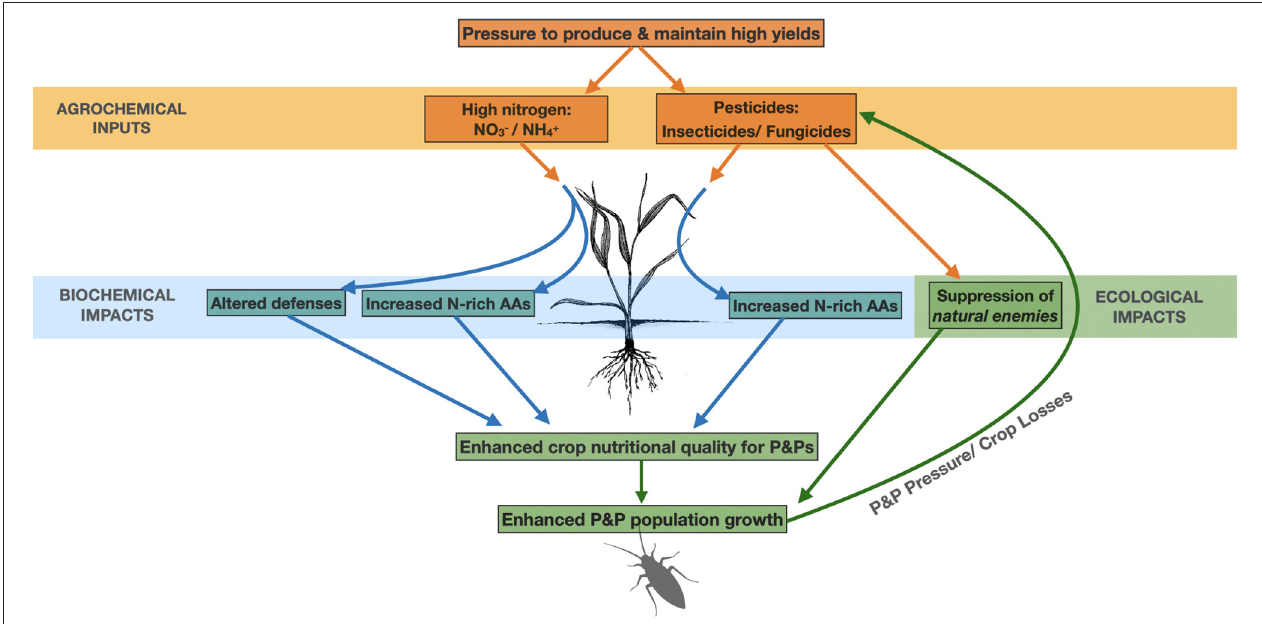
FIGURE 1 | Pathways via which the un-intended impacts of N-fertilisers and/or pesticides may reinforce the problem of pest and pathogen (P&P) damage in agriculture. Both N-fertilisers and/or pesticides can enhance the biochemical susceptibility of crops to P&P damage, by enhancing concentrations of highly valuable nutritional compounds within crop tissues (e.g., N-rich amino acids (AAs)). In addition, N-applications can result in changes to crops’ expression of the defensive traits that serve to protect them against P&P organisms. Finally, pesticide applications can enhance crops’ ecological susceptibility to P&P damage by suppressing the “natural enemies” (e.g., predators and parasitoids) of P&P species. These impacts (either alone, or in combination) may stimulate P&P population growth and precipitate damage to crops, and this may result in the need for further pesticide applications (orange arrows, agrochemical inputs; blue arrows, biochemical impacts; green arrows, ecological